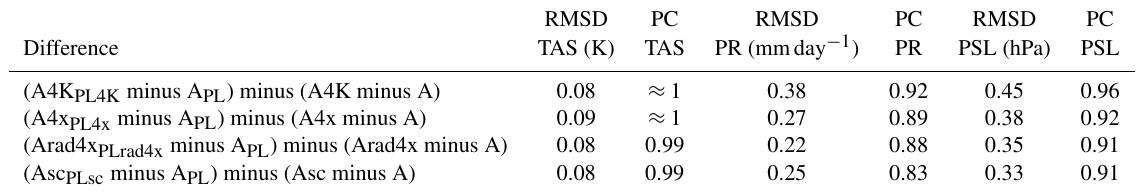
“ ≈ 1 ” implies that the correlation coefficient is not unity but rounds to unity when only two decimal places are considered.